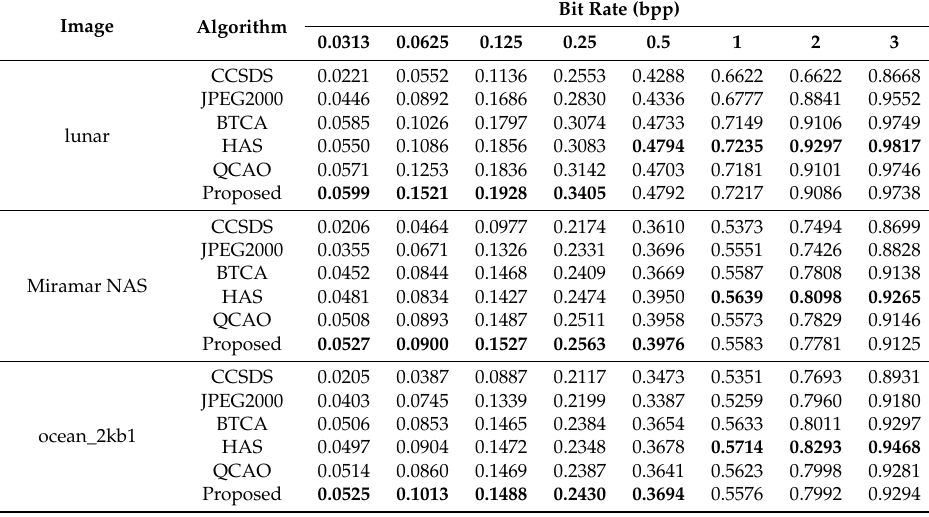
Table 5. VIF S (dB) of the proposed compression method and other scan-based compression